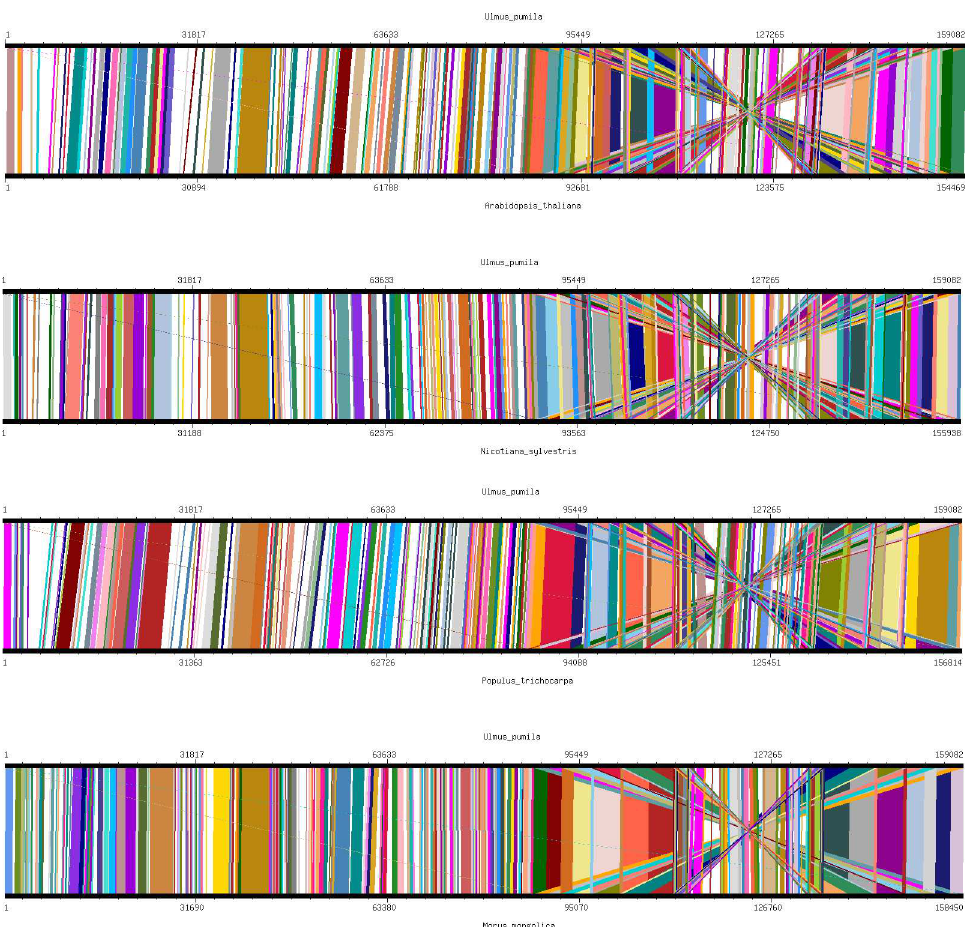
Fig 2. Co-linear analysis of various plant chloroplast